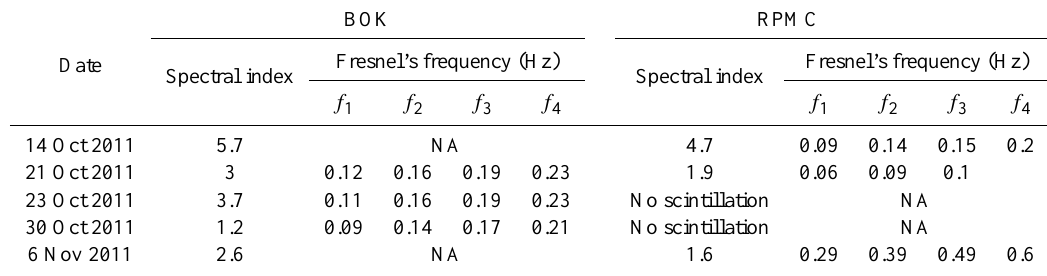
Table 2. Spectral features corresponding to some isolated scintillation events at BOK and RPMC (Sect. 3.2). BOK RPMC Fresnel’s frequency (Hz) Date Spectral index Spectral